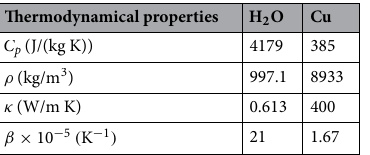
Table 1. Thermodynamical properties of nanofluids (Oztop et al. 24 ).